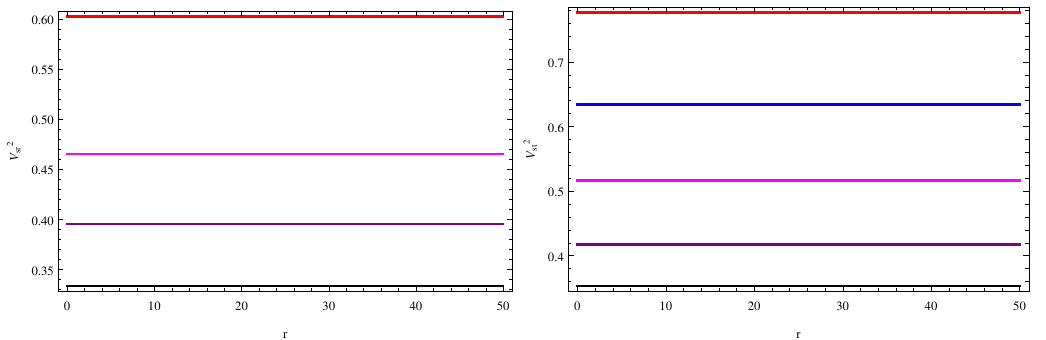
Figure 7. Plot of v 2 and v 2 sr versus r for the strange star candidate LMC X − 4. The red, purple, magenta, st blue and black colors represent respectively cases (cid:118) = 0, (cid:118) = 0.5, (cid:118) = 1, (cid:118) = 1.5 and (cid:118) =